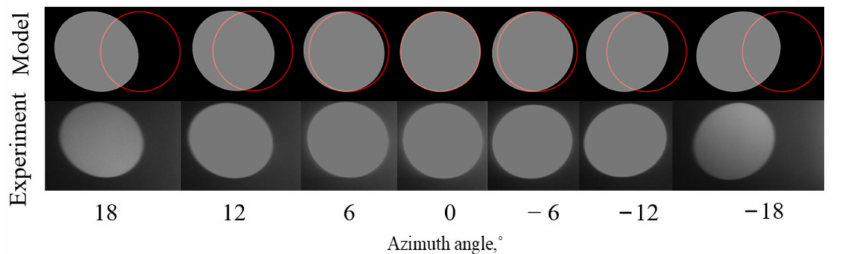
Figure 10. Simulated (upper row) and experimental (lower row) images with the AOTF tuned to λ = 632.8 nm ( f = 72.84 MHz) for different angles of incident light in the azimuth plane. The solid red line in the upper row indicates the ideal positions of the integrating sphere with the assumption of pinhole